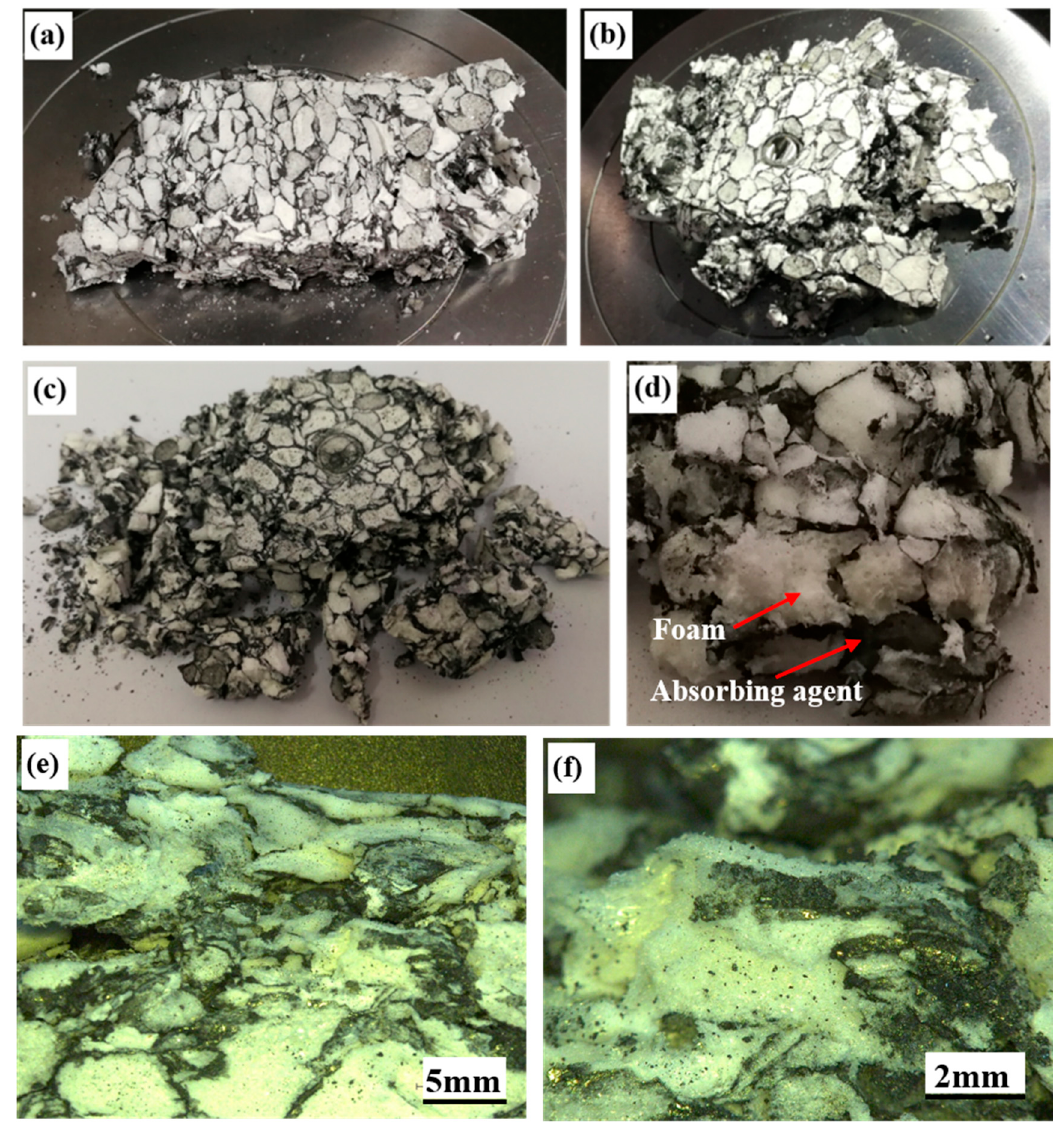
Figure 8. Absorbent PMI foam-based specimen images after compression. ( a ) Absorbent PMI foam; ( b ) Tube-enhanced absorbent PMI foam; ( c ) Foam-filled tube-enhanced absorbent PMI foam; ( d ) Fractography of the absorbent PMI foam showing interfaces between PMI foam and absorbing agent; ( e ) and ( f ) Local fracture surfaces of the absorbent PMI foam.